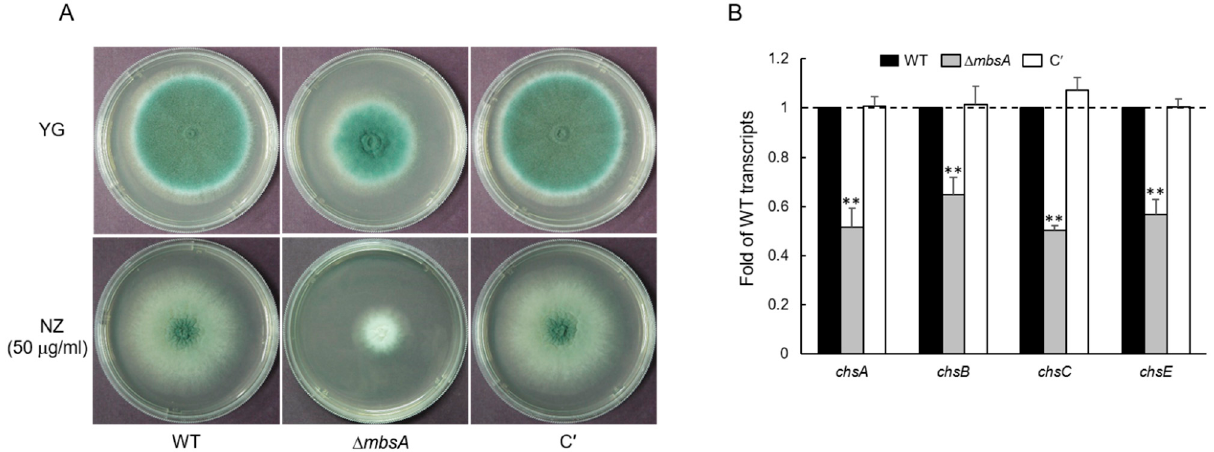
Figure 3. MbsA is necessary for the proper regulation of chitin synthesis. ( A ) Radial growth of WT, Δ mbsA , and C ′ strains in the presence of Nikkomycin Z (NZ, 50 µg/mL) following incubation at 37 °C for 72 h. ( B ) Chitin synthesis–related genes in WT, Δ mbsA , and C ′ strains analyzed by RT-qPCR. The ef1 α gene as the endogenous control. Statistical differences between strains were evaluated with ANOVA test: ** p < 0.01.